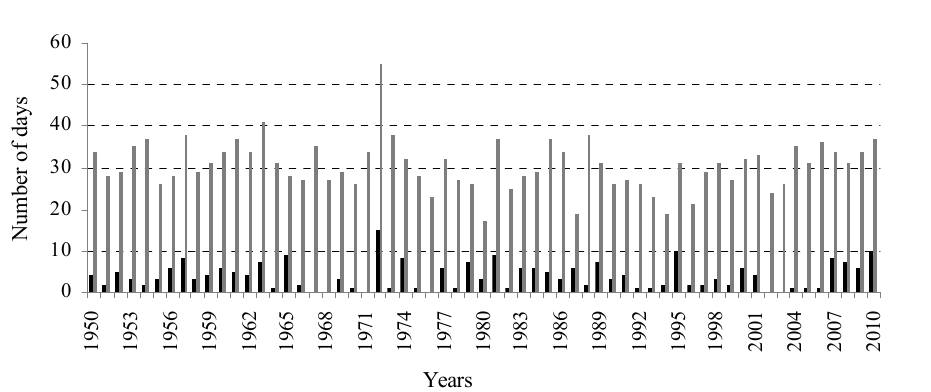
Fig. 3. Number of days with a southern cyclone (black) and other events (grey) in the circle-1K around Estonia, which were associated with thunderstorms in